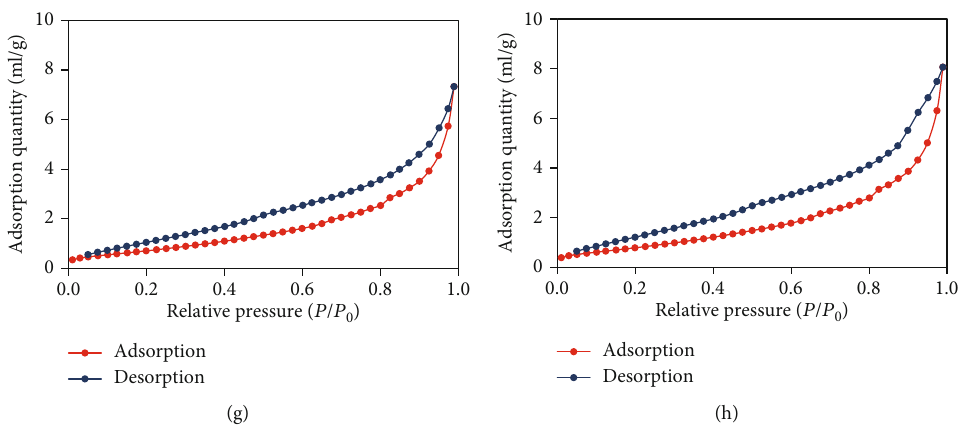
Figure 4: N adsorption isotherms of di ff erent mudstones. (a) H-1: pure mudstone; (b) H-2: pure mudstone; (c) H-3: pure mudstone; 2 (d) H-4: silty mudstone; (e) H-5: silty mudstone; (f) H-6: silty mudstone; (g) H-7: sandy mudstone; (h) H-8: sandy